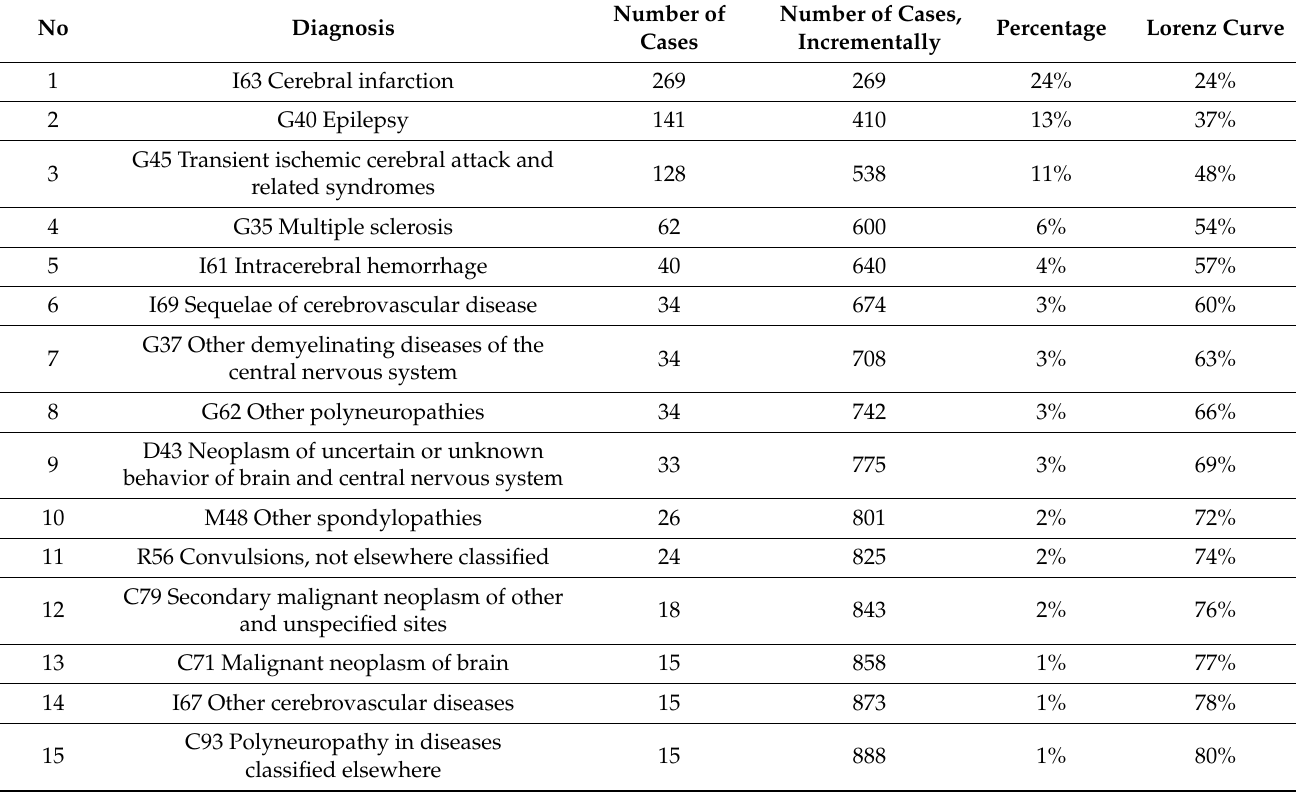
Table 2. A list of study-specific